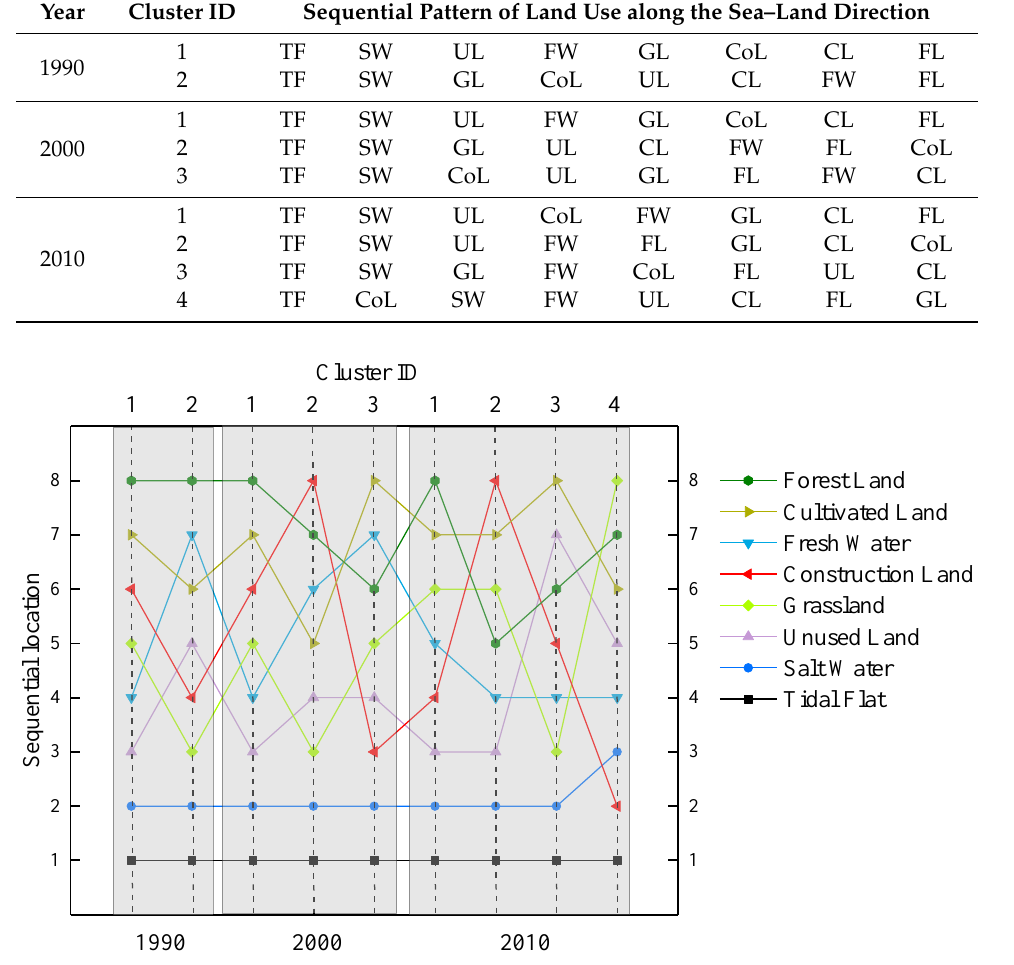
Figure 7. The sequential number of each land-use type in the CLUSPs from 1990 to 2010.